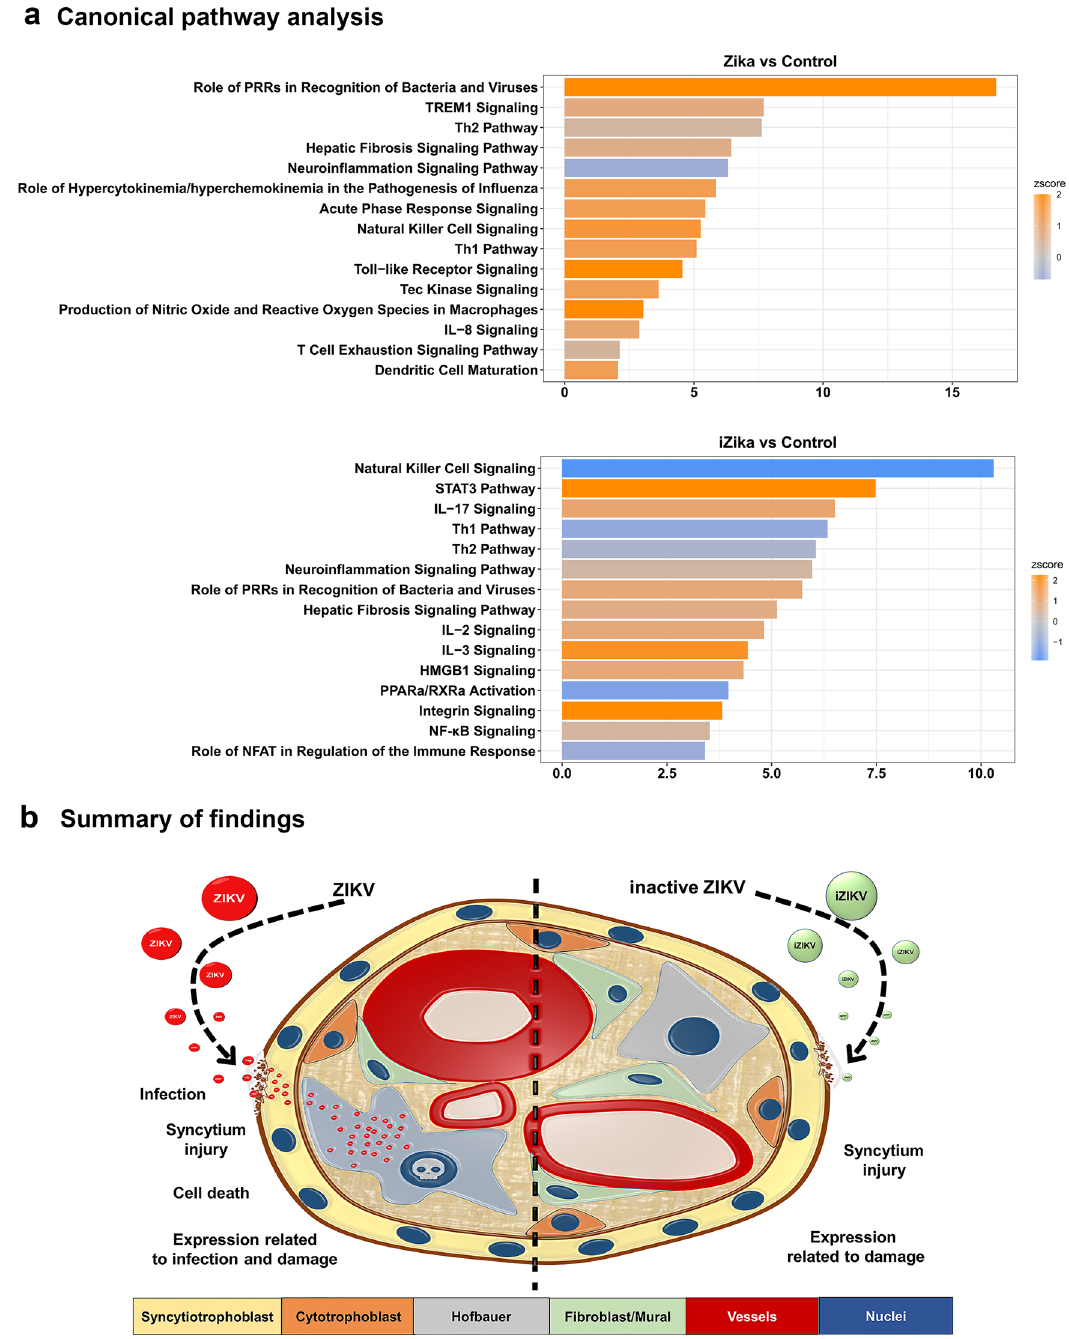
Fig. 10 Network analysis and synopsis. a Bar charts of signi fi cantly enriched IPA canonical pathways for ZIKV vs. control (top graph) and iZIKV vs. control (bottom graph) DE genesets. Bars represent each canonical pathways p value on a negative logarithmic scale. The top 15 pathways related to immunity and in fl ammation are ranked based on p value ≤ 0.05. Bars are shaded according to their z-score activity predictions. Orange represents pathways with positive z-scores and depicts pathway activation; blue represents pathways with negative z-scores and depicts pathway inactivation. PRRs denote Pattern Recognition Receptors. b Summary of fi ndings and potential model of ZIKV transmigration across the maternal-fetal